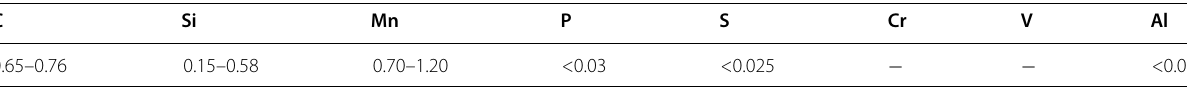
Table 2 Mass fraction of chemical composition of U71MnG rail steel